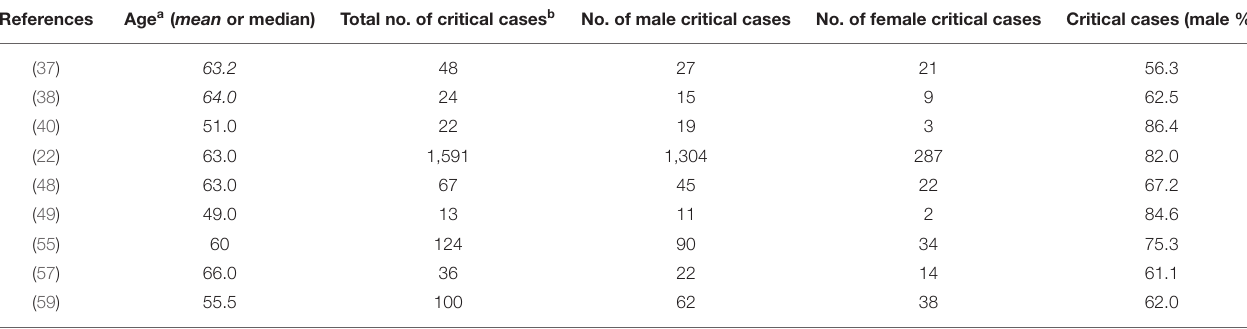
TABLE 5 | All critical cases of COVID-19 included in the meta-analysis.